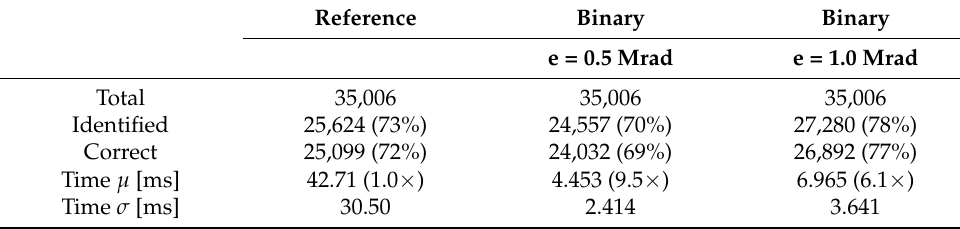
Table 7. Comparison of star identification algorithms, FOV =